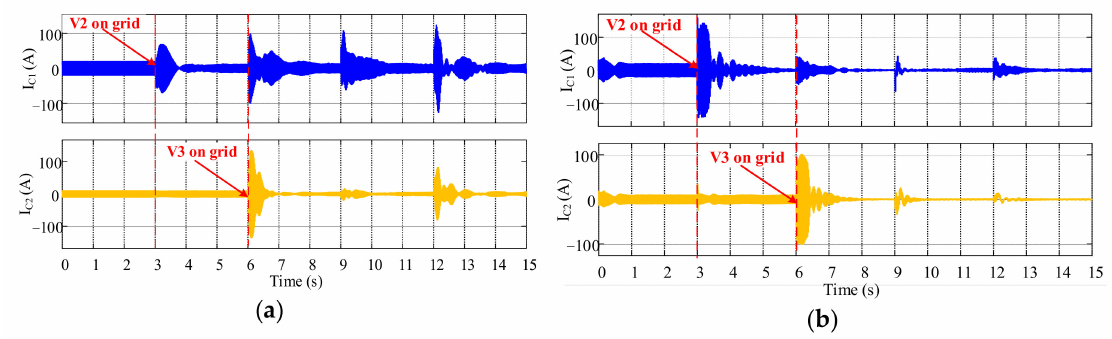
Figure 9. The circulation currents when they were connected with the traction grid without a load: ( a ) the traditional control strategy; ( b ) the proposed strategy.